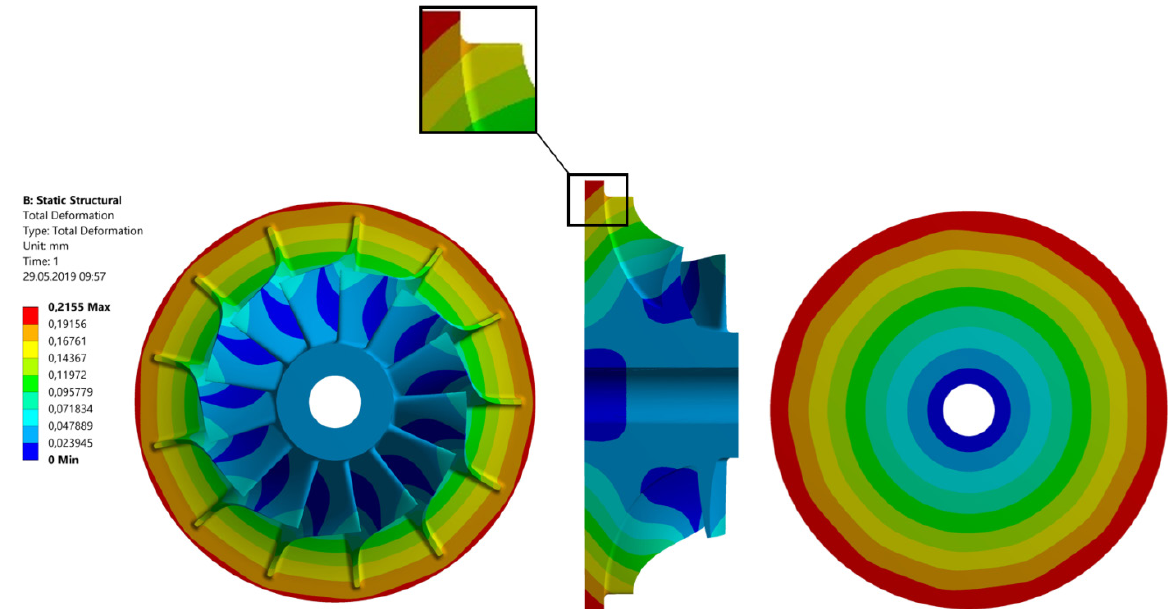
Figure 15: Deformation distribution of base turbine disc (rotational speed – 96,000 rpm; Temperature – 600 ∘ C)